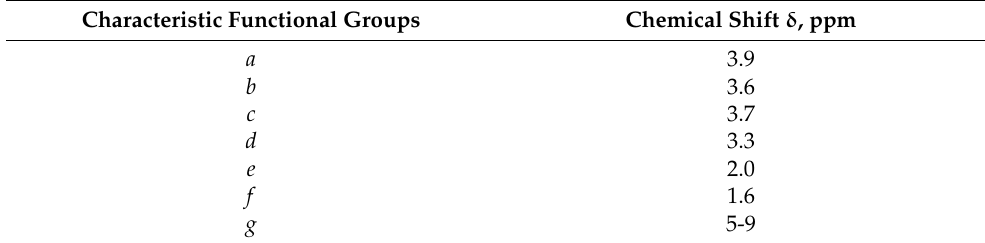
Table 2. 1 HNMR analysis of the synthetic polyurethane.